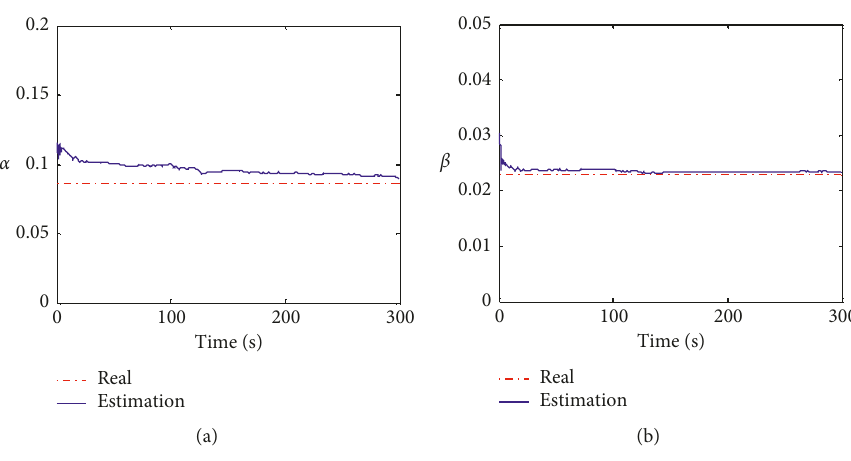
Figure 19: Estimation results of damping coefficients. Table 13: Estimation values and errors of structural parameters. Structural parameter True value Estimated value Errors